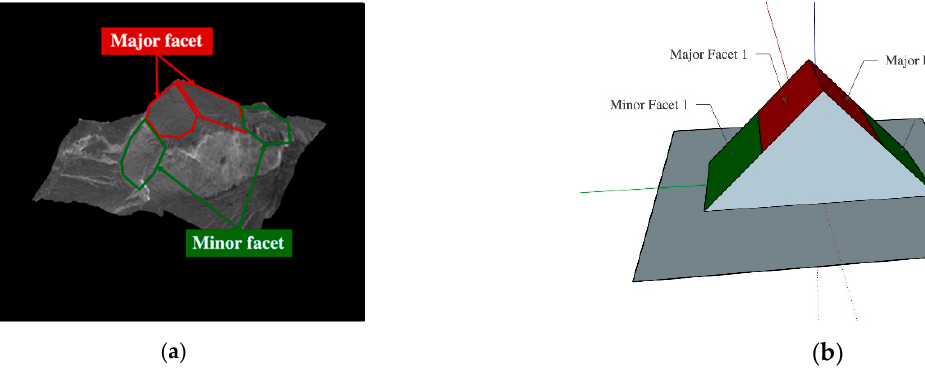
Figure 11. Example of the combination type. These facets are the same facets shown in Figure 7b ( σ max = 625 MPa, R = − 1, N f = 2.0 × 10 7 ). ( a ) 3D-SEM image; ( b ) 3D-model schematic image.